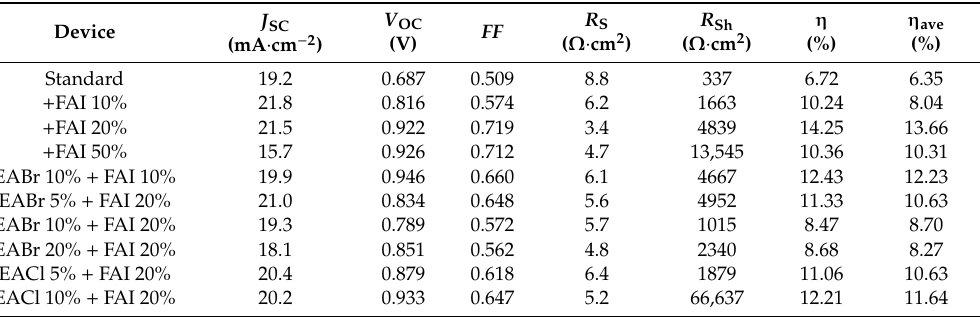
Table 2. Measured parameters of the cells fabricated in this study. J SC : short-circuit current density. V OC : open-circuit voltage. FF: fill factor. R S : series resistance. R Sh : shunt resistance. η : conversion efficiency. η ave : averaged efficiency of three cells.